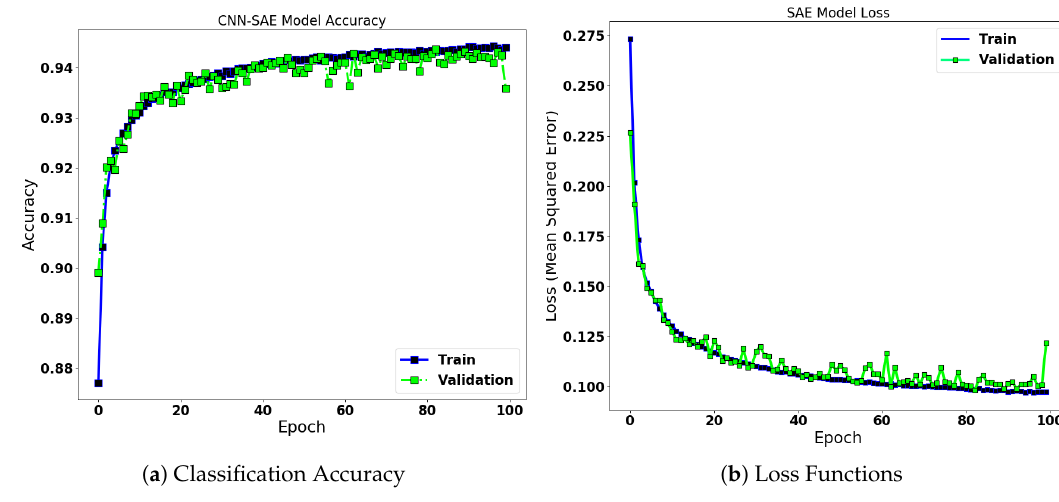
Figure 8. CNN-SAE Architecture: Five-Status Classification Performance.